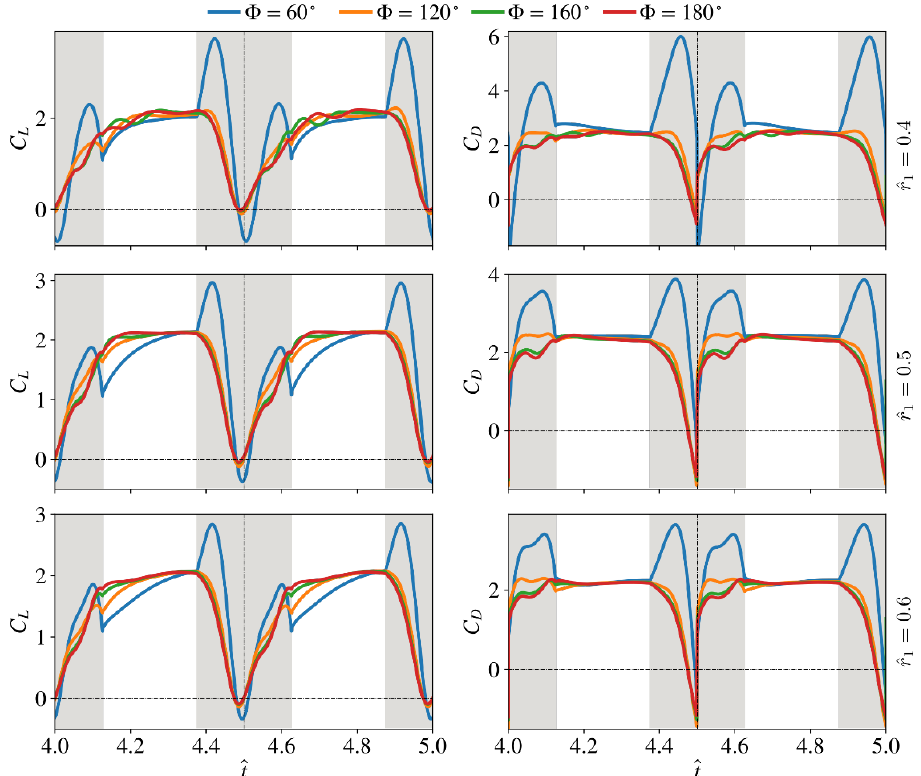
Figure 13. Variations of the lift and drag coefficients for different stroke amplitudes and radial centroid locations. Wing translational phases are indicated by white shading; wing rotational phases are indicated by grey shading.